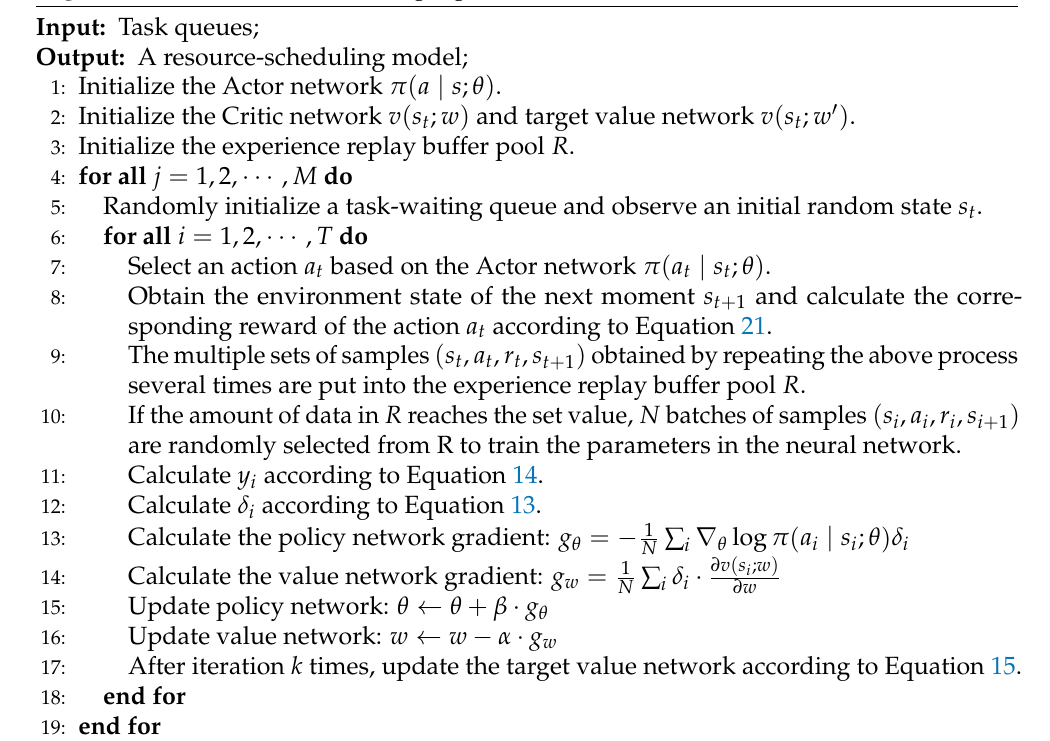
Algorithm 1 A resource-scheduling algorithm based on